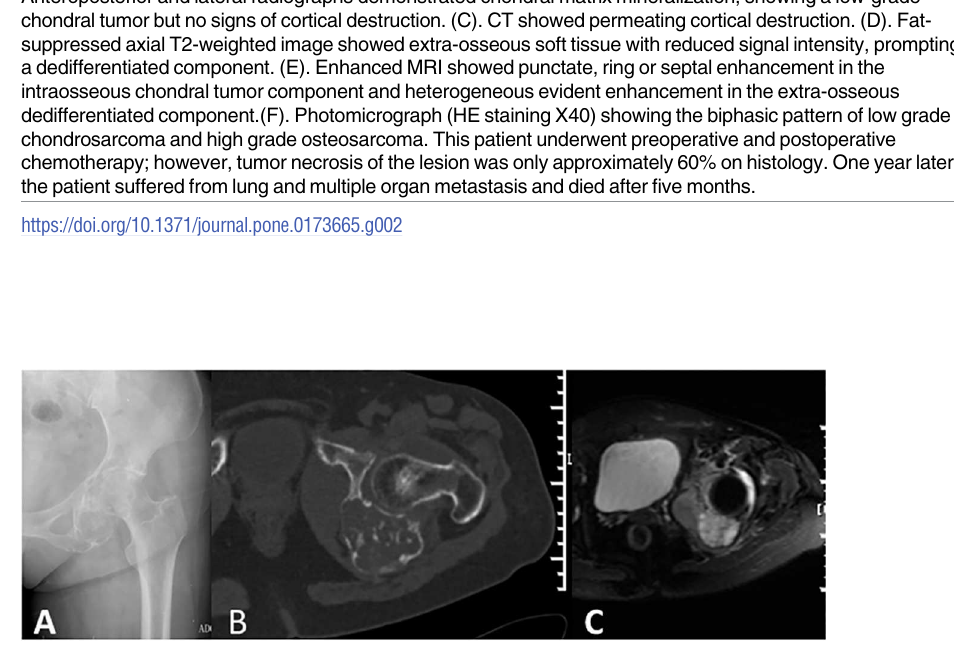
Fig 3. Dedifferentiated chondrosarcomaof the left pelvis in a 59-year-oldwoman (Case12). (A). Anteroposteriorradiographdemonstrated unilaminar benignperiostealreactionandlow-gradechondrosarcoma. (B).CT showedexpansiveosteolyticbonedestruction withtypical chondral matrix mineralization andextra- osseousunmineralizedsoft tissuea mass cluingdedifferentiated component. (C). Fat-suppressed coronal T2-weighted imageshowedcleardemarcationbetweenreducedsignalintensity(dedifferentiated component) andchondral signalintensity.The preoperative needlebiopsywas accuratebasedon